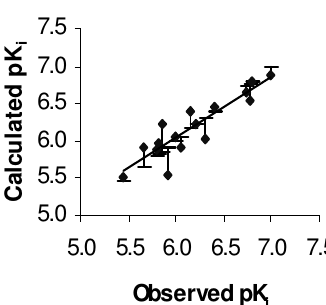
Figure 1. Plot between observed pK